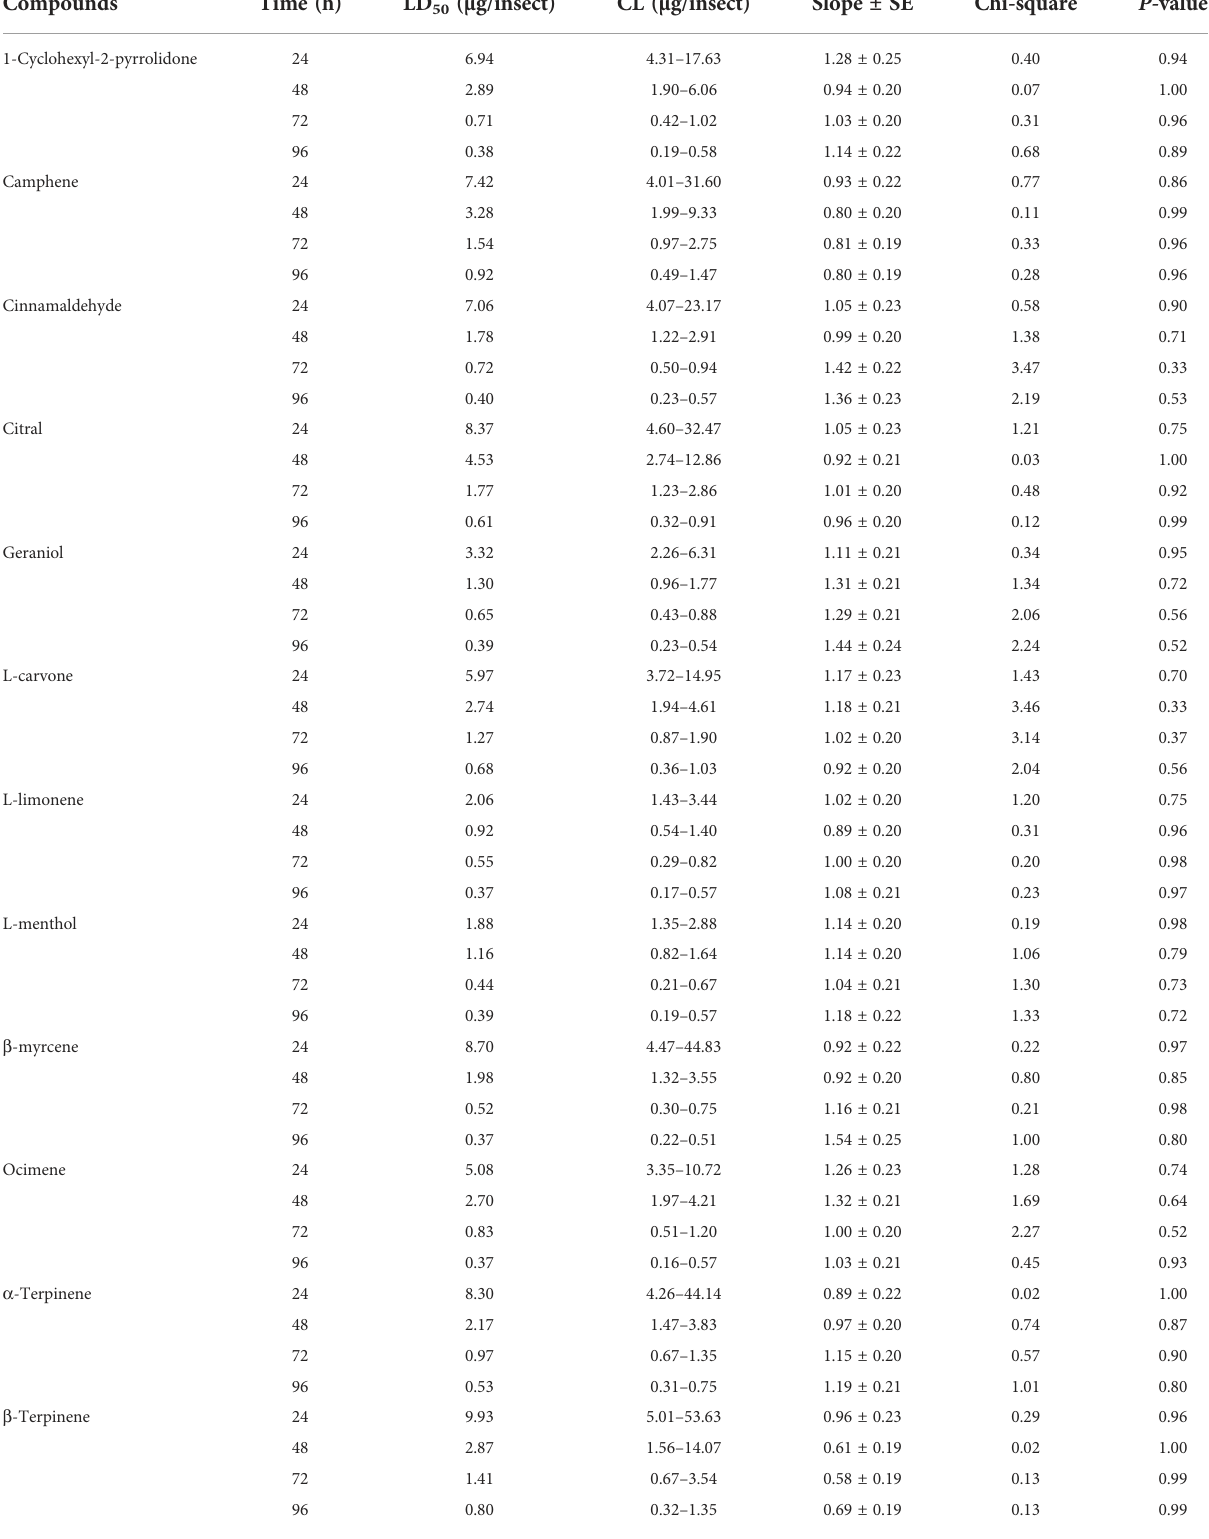
TABLE 1 Toxicity of various compounds against the second instar crawlers of P. lilacinus .